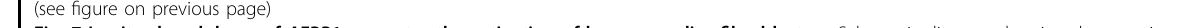
Fig. 7 In vitro knockdown of AEBP1 promotes the activation of human cardiac fi broblasts. a Schematic diagram showing the experimental procedure of AEBP1 knockdown. Three independent experiments were performed for each group. Normal human ventricular cardiac fi broblasts (passage 5-7) were used. b Bright- fi eld images showing the cardiac fi broblasts after 48 h of transfection. Scale bar: 200 μ m. c Phalloidin staining of actin fi laments showing the morphological changes of cardiac fi broblasts caused by AEBP1 knockdown. Scale bar: 50 μ m. d Ki67 staining showing that AEBP1 knockdown reduced the proliferation of cardiac fi broblasts. In the bar plot, each value represents the mean number of Ki67-positive cells across fi ve representative fi elds of view. Scale bar: 20 μ m. ** P -value < 0.01, Student ’ s t -test. e mRNA expression of AEBP1 and markers for fi broblast activation in both groups. The expression level is represented as tags per million reads. f Network plot showing the functional enrichment of the upregulated genes in AEBP1 -siRNA versus scrambled siRNA. g Network plot showing the functional enrichment of the downregulated genes in AEBP1 -siRNA versus scrambled siRNA. In f and g , each node denotes an over-represented Reactome pathway, and the node size re fl ects the statistical signi fi cance. Functionally associated terms were in the same color. The enrichment signi fi cant threshold was set to an adjusted P -value < 0.05. h Western blot assay showing the changes in protein expression of AEBP1 and representative fi broblast activation markers by the knockdown of AEBP1 . i Immuno fl uorescence staining of cultured fi broblasts showing an increased protein expression level of Collagen-I by the knockdown of AEBP1 . Scale bar: 50 μ m. j Quantitative analysis of the western blot and staining results. For bar plots, the data are presented as means±standard error of the mean (SEM). For the staining results, each value represents the mean fl uorescence intensity across fi ve representative fi elds of view. * P - value < 0.05, ** P -value < 0.01, *** P -value < 0.001. Student ’ s t